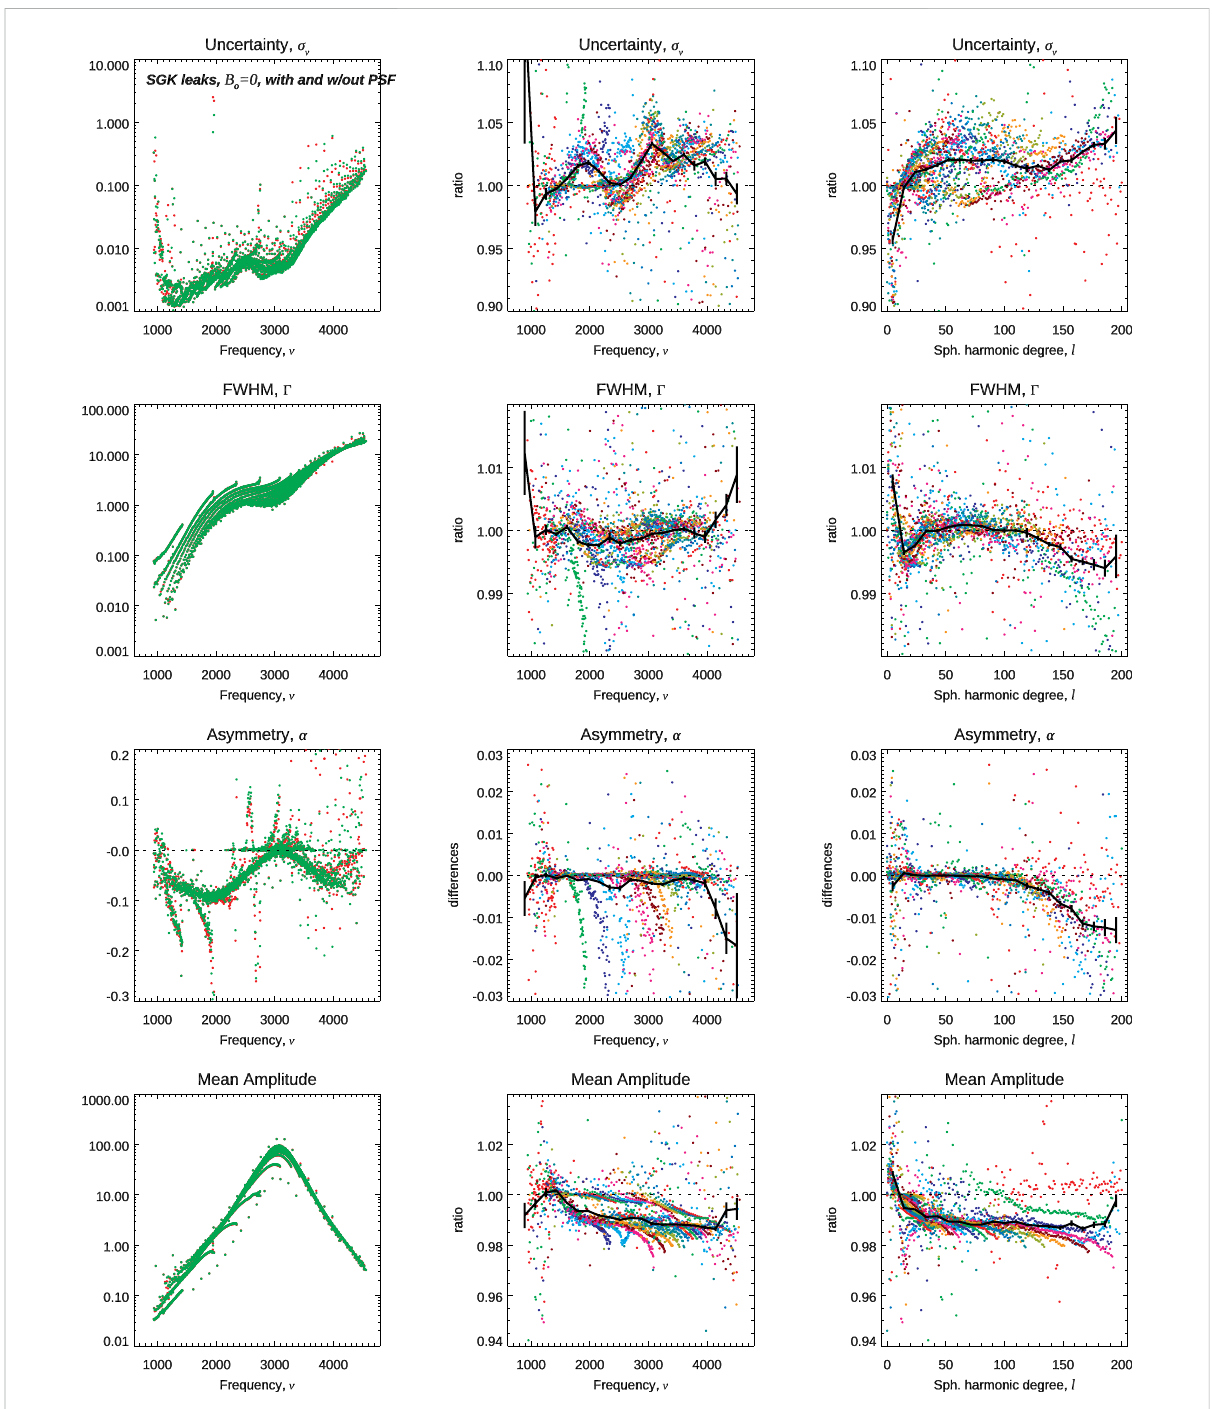
FIGURE 2 Comparison of multiplets ’ characteristics when fi tting using a leakage matrix that either include or does not include the effect of the PSF. From top to bottom, the uncertainty on the frequency, FWHM, the asymmetry, and the mean amplitude are shown, color-coded on the leftmost column for the two cases, and as either ratios or differences on the two rightmost columns, namely, versus ] or versus  . The thick black lines show the resulting binned values, while the color coding corresponds to the mode radial order, n